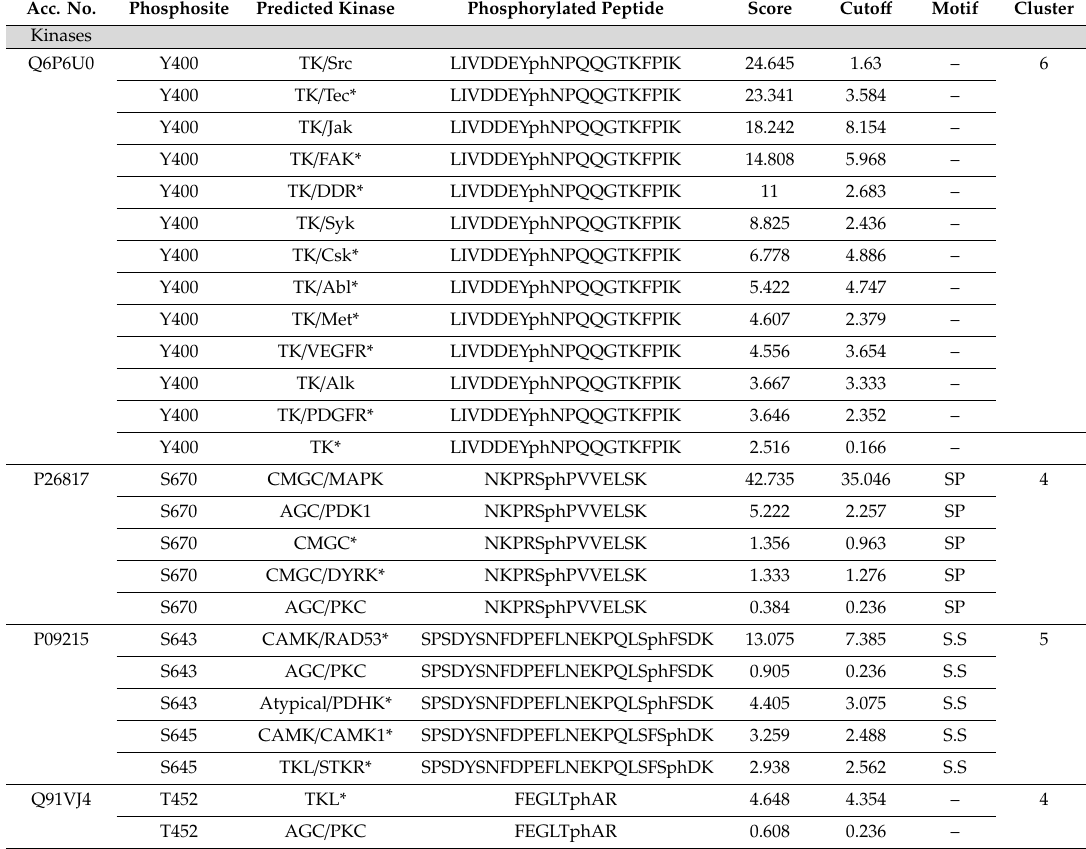
Table 3. Enriched motifs found in the regulated